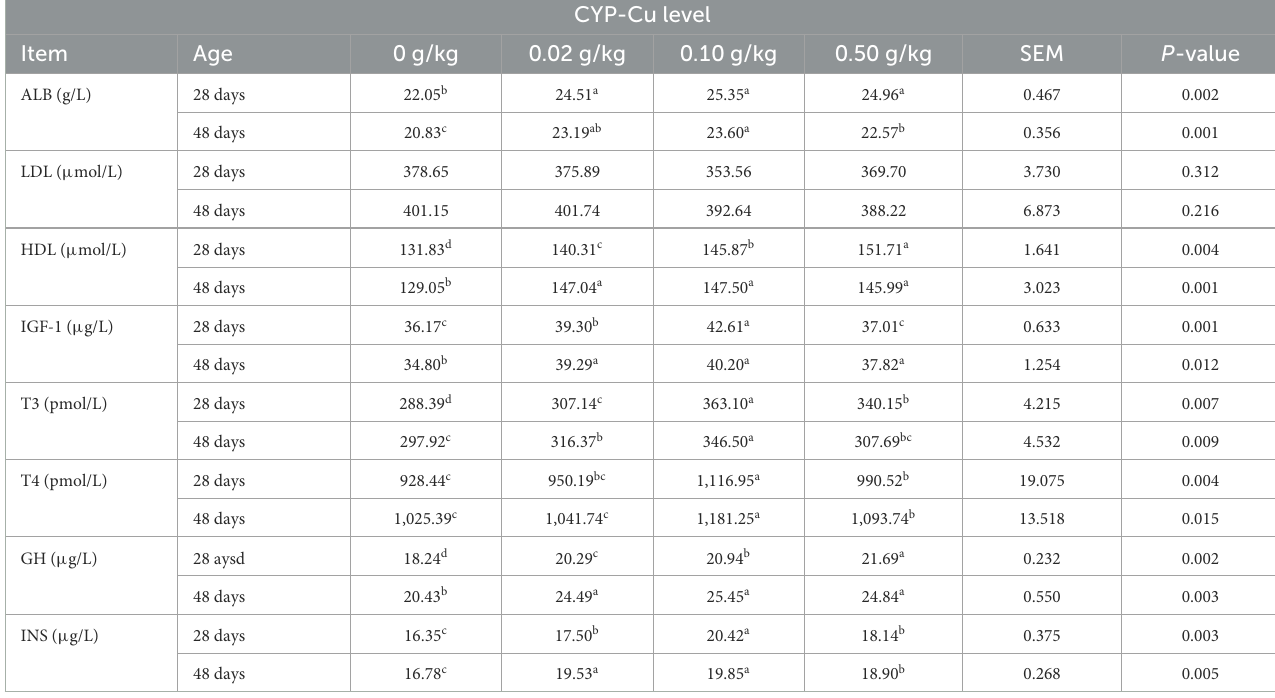
TABLE 5 Effects of dietary CYP-Cu on serum growth factors and biochemical parameters in